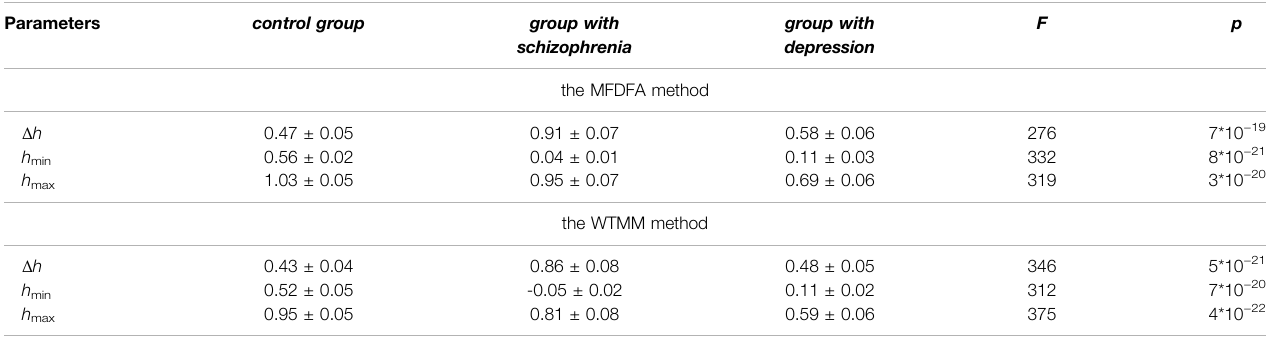
TABLE 1 | Comparison of the averaged (over subjects) maximal and minimal values of the Holder exponent ( h min and h max ) and the width of the singularity spectrum, Δ h , for different groups, the values of the Fisher test ( F ) and the signi fi cance level of the test ( p ), calculated on the basis of one-way analysis of variance (O1 site). Parameters